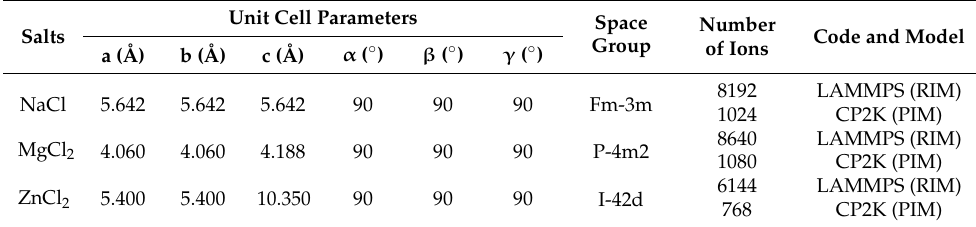
Table 3. Details of simulations for chloride salts at solid